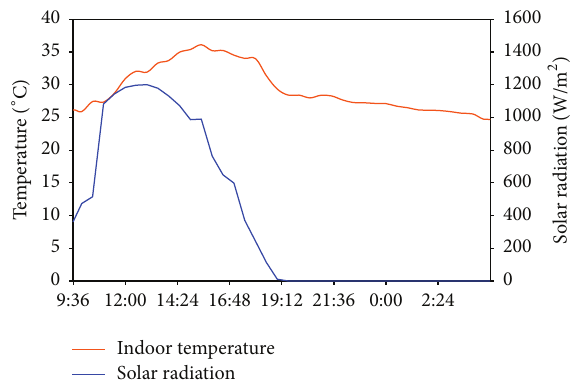
Figure 5: Variation of indoor temperature with solar radiation (5 November).